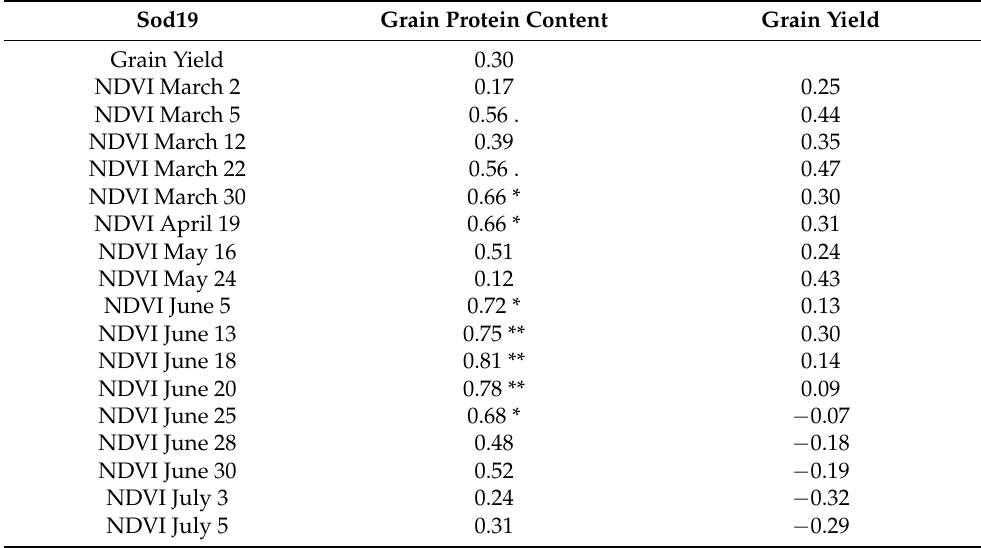
Table 9. Pearson correlation analysis and significance levels (. = 0.10; * = 0.05; ** = 0.01) between NDVI, grain yield, and protein content for the Sod19